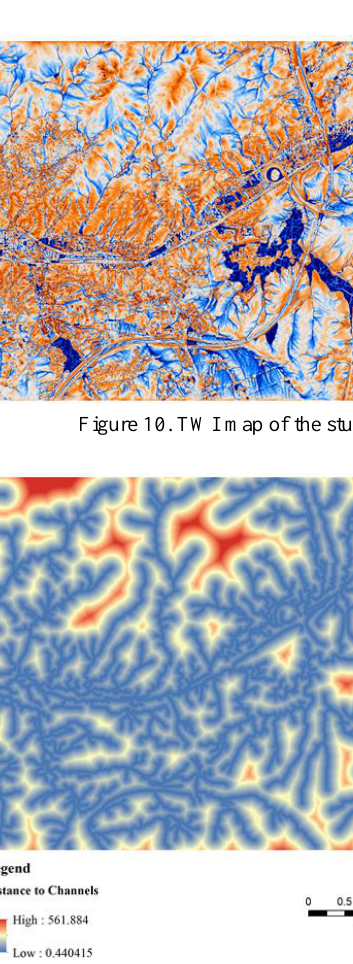
Figure 9. SPI map of the study area